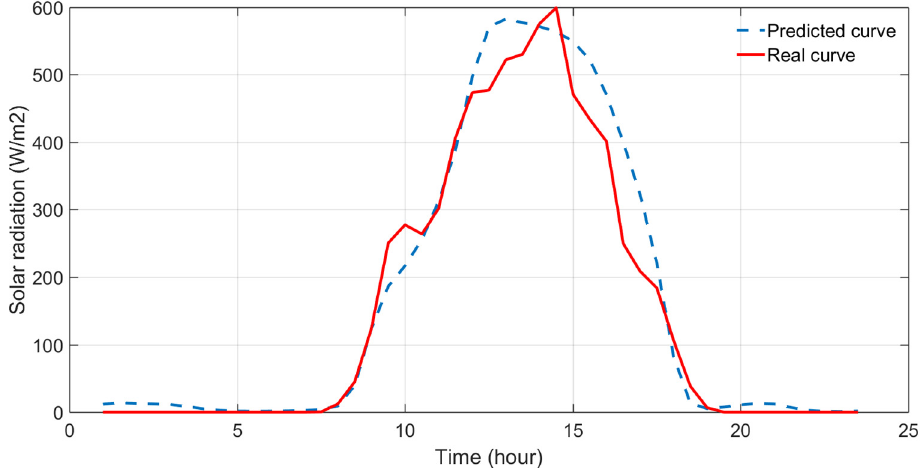
Figure 14. Predicted curve of the direct solar radiation when using the best obtained simulation